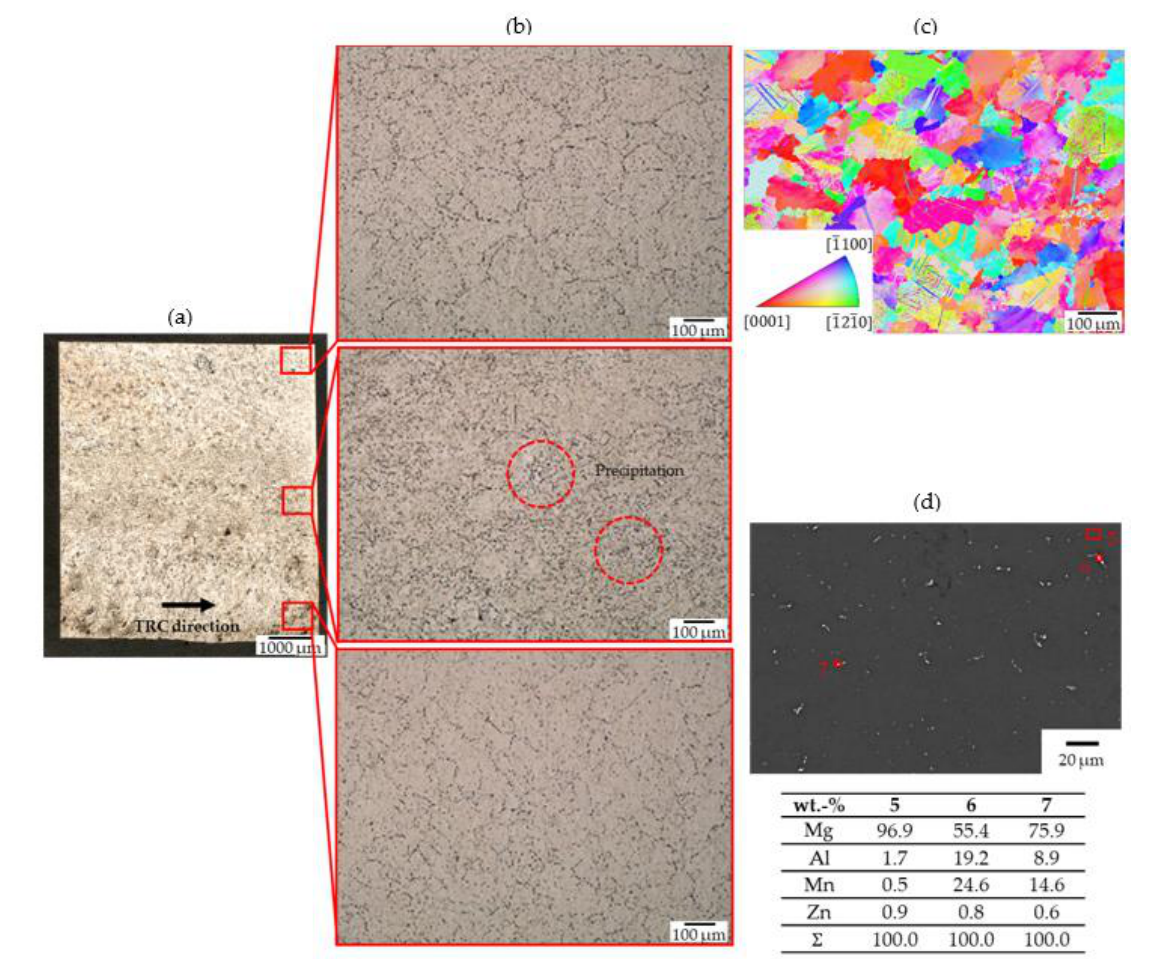
Figure 5. Twin-roll cast and heat-treated condition in longitudinal view, ( a ) general view (segregations almost completely reduced), ( b ) detailed view from the upper edge (grain refinement), from the centre (precipitations) and from the lower edge (grain refinement), ( c ) EBSD measurement peripheral zone and ( d ) EDS measurement centre area of